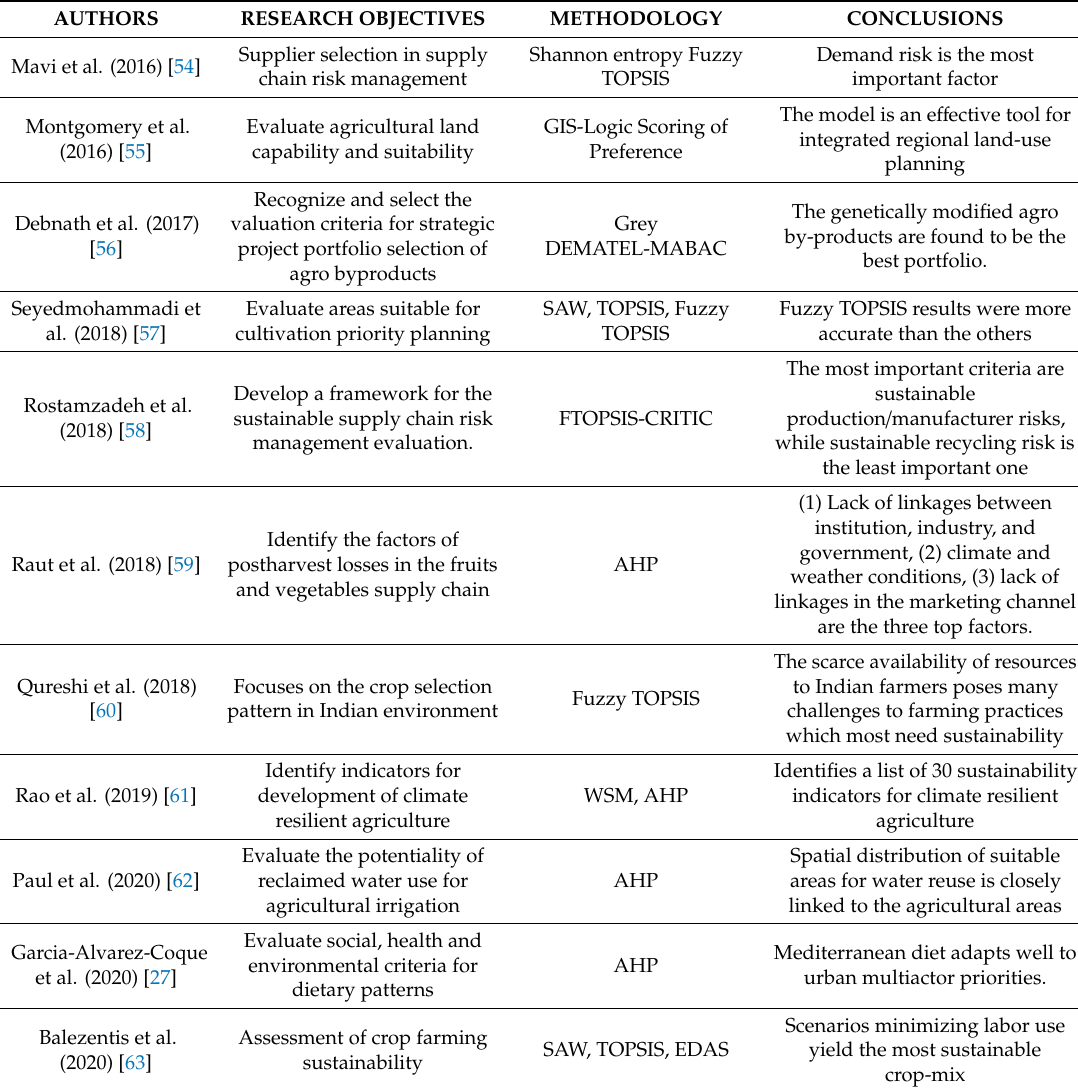
Table 1. Overview of papers on decision processes in the agricultural and food